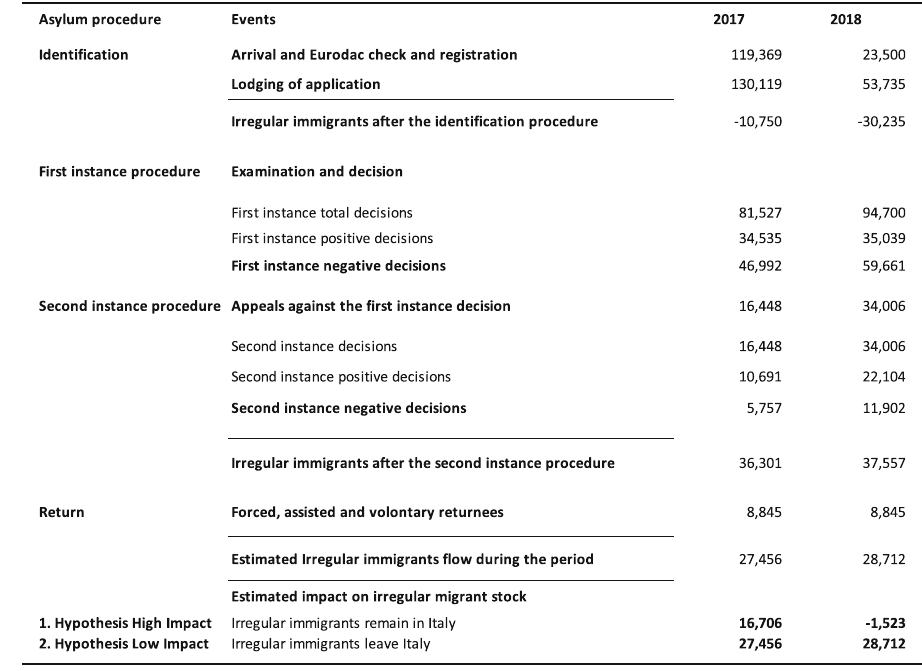
Table 3 Summary of migration events occurred in Italy, 2017 (data sources: Ministry of Interior); estimations related to 2018 events and the changes of irregular migrant stock due to new sea arrivals at the end of 2017 and